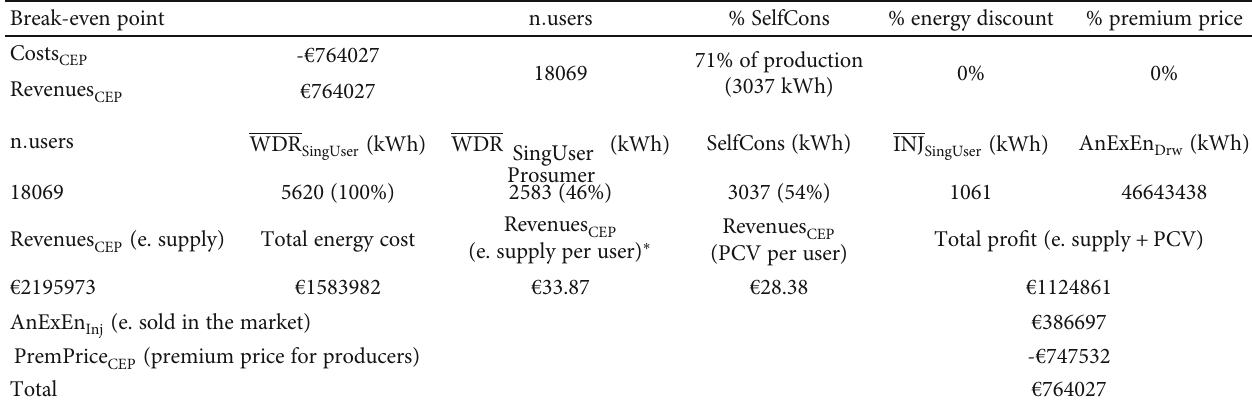
Table 3: Numerical results for 2016 tari ff